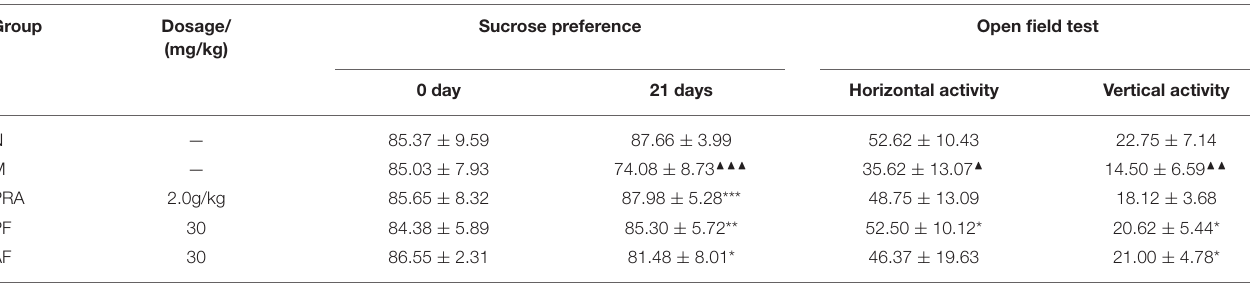
TABLE 1 | Changes in the sucrose preference and open field test among groups ( n = 8, ± s). Group Dosage/ Sucrose preference Open field test (mg/kg) 0 day 21 days Horizontal activity Vertical activity